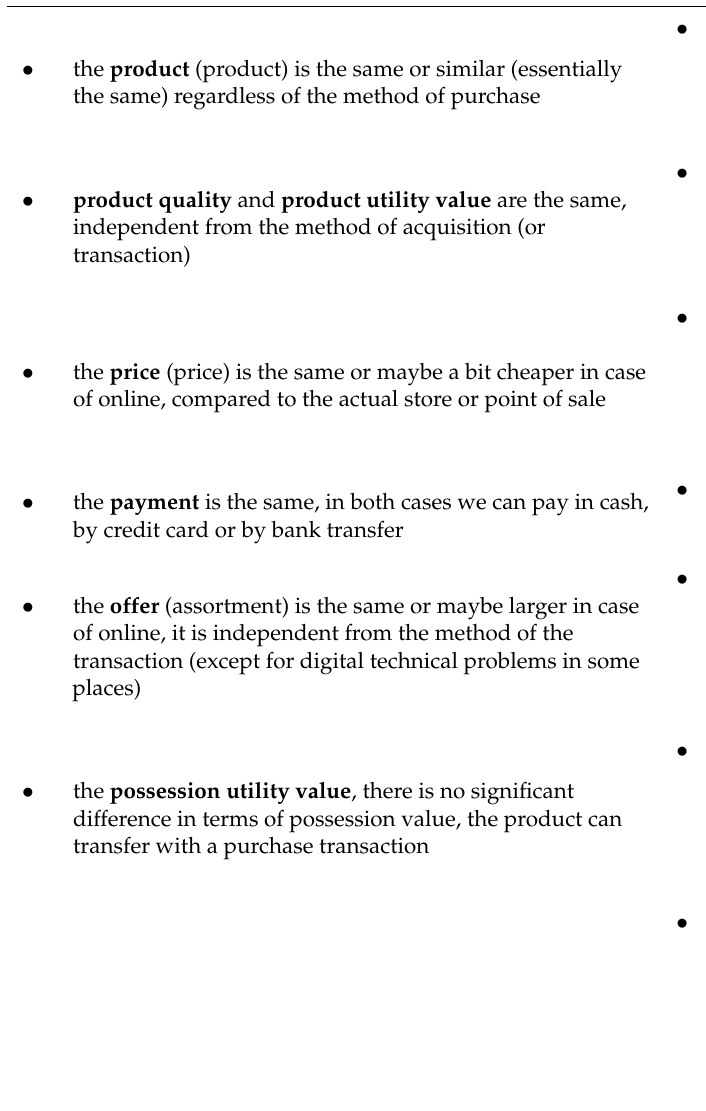
Table 1. Similarities/differences between e- or m-commerce and traditional commerce.